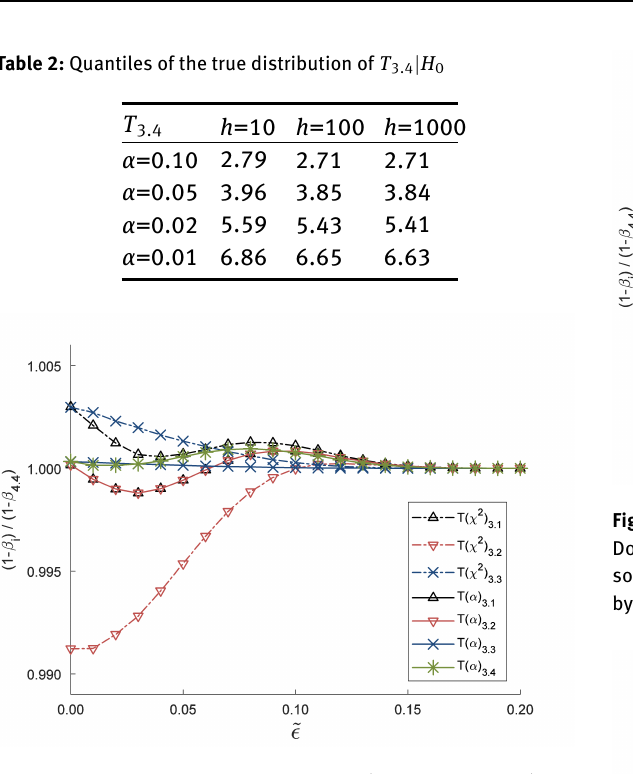
Figure 4: Power function ratios for h =1000 (weak non-linearity). Dotted curves: using χ 2 (1) -quantiles and are denoted by T (︀ χ 2 )︀ , solid curves: using true quantiles for critical values and are denoted by T ( α ) . Black and red solid curves visually overlap.